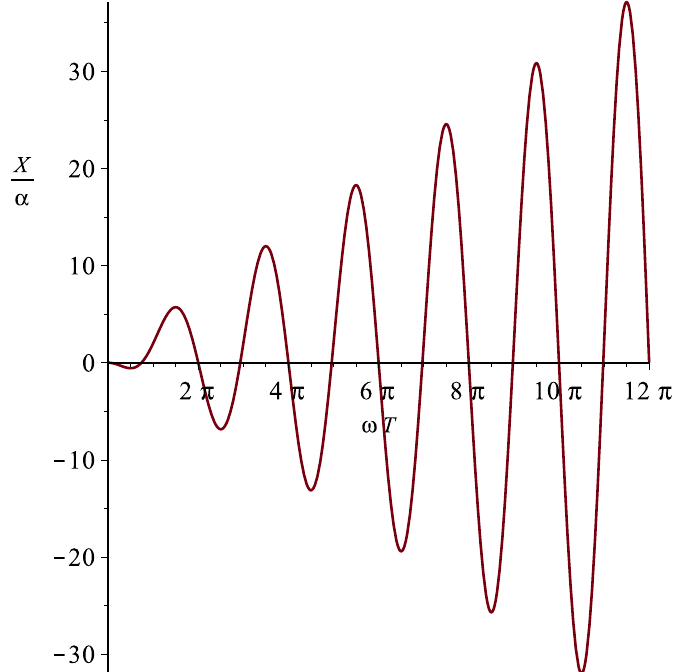
Figure 1. The behavior of the particle coordinate parallel to the wave propagation direction; we set 2 A + α = V 0 c